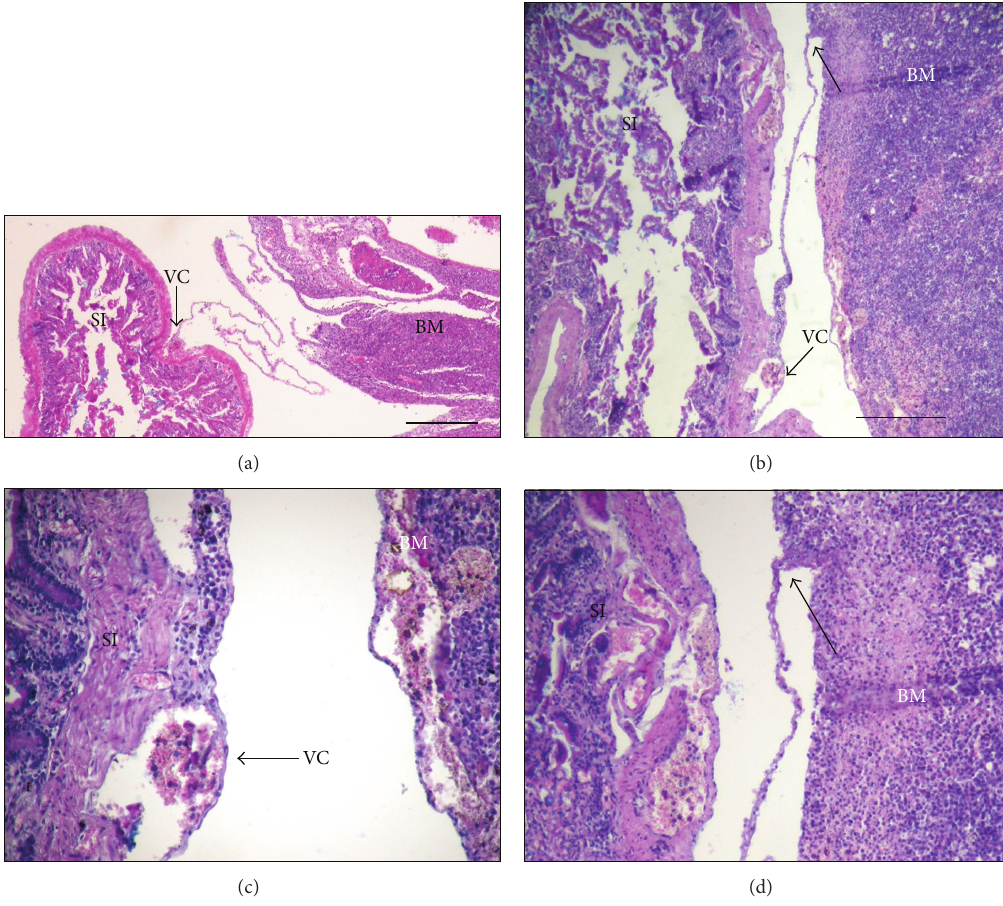
Figure 2: Vascular connections of the bigger mass to the small intestine. (a) Photomicrograph showing the vascular connection (VC, arrows) between the bigger mass (BM) and the serosa layer of the small intestine (SI). (b) Another vascular connection (arrows) between the same structures. H/E staining. Calibration bars: (a) = 223 𝜇 m; (b) = 223 𝜇